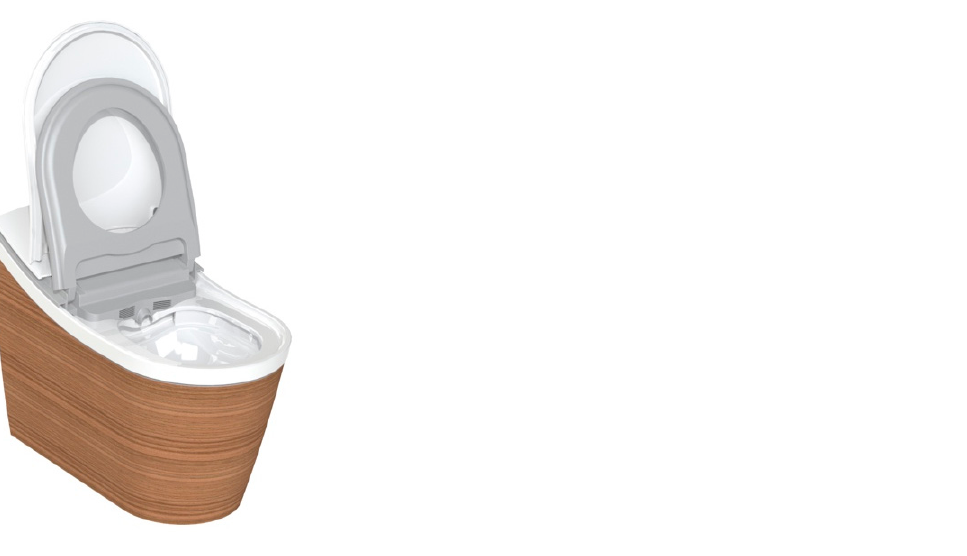
Figure 1. Rendering of the innovative multifunctional toilet (WashOne). Source: Developed by a subset of authors.